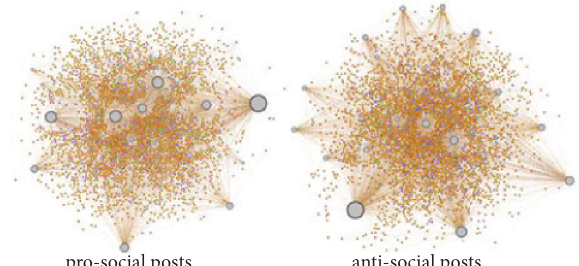
Figure 2: Topology of Weibo post